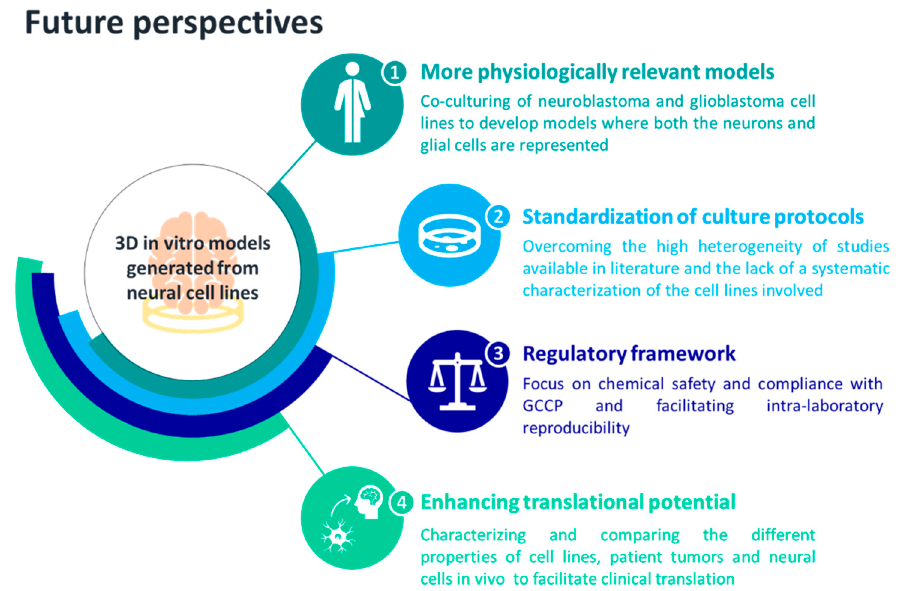
Figure 2. Future perspectives proposed for exploiting neural cell lines in 3D culture systems.